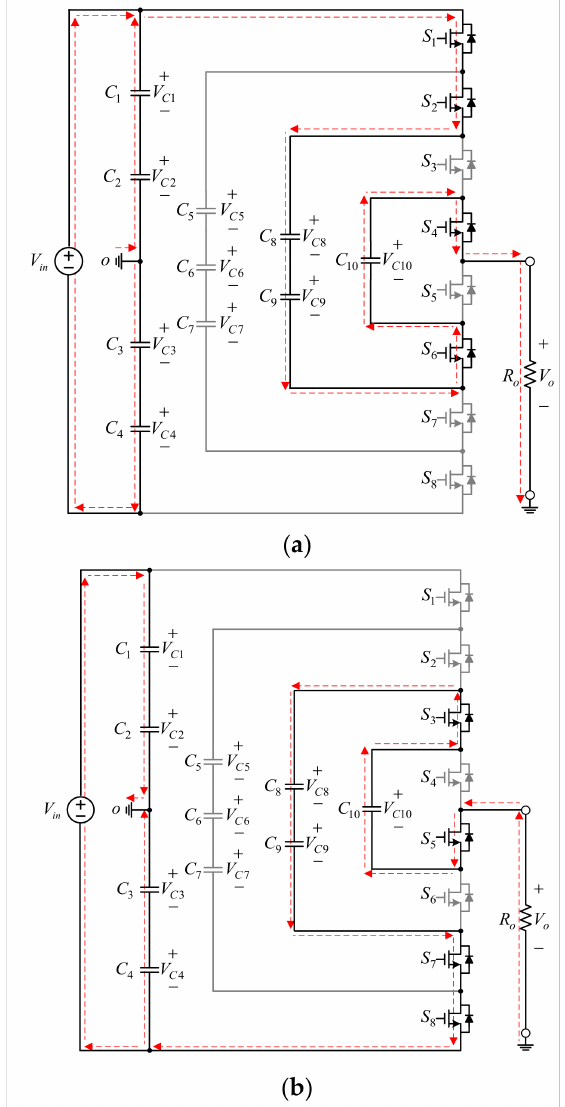
Figure 9. ( a ) Current flow direction of 0.25 V in voltage output; ( b ) current flow direction of − 0.25 V in voltage